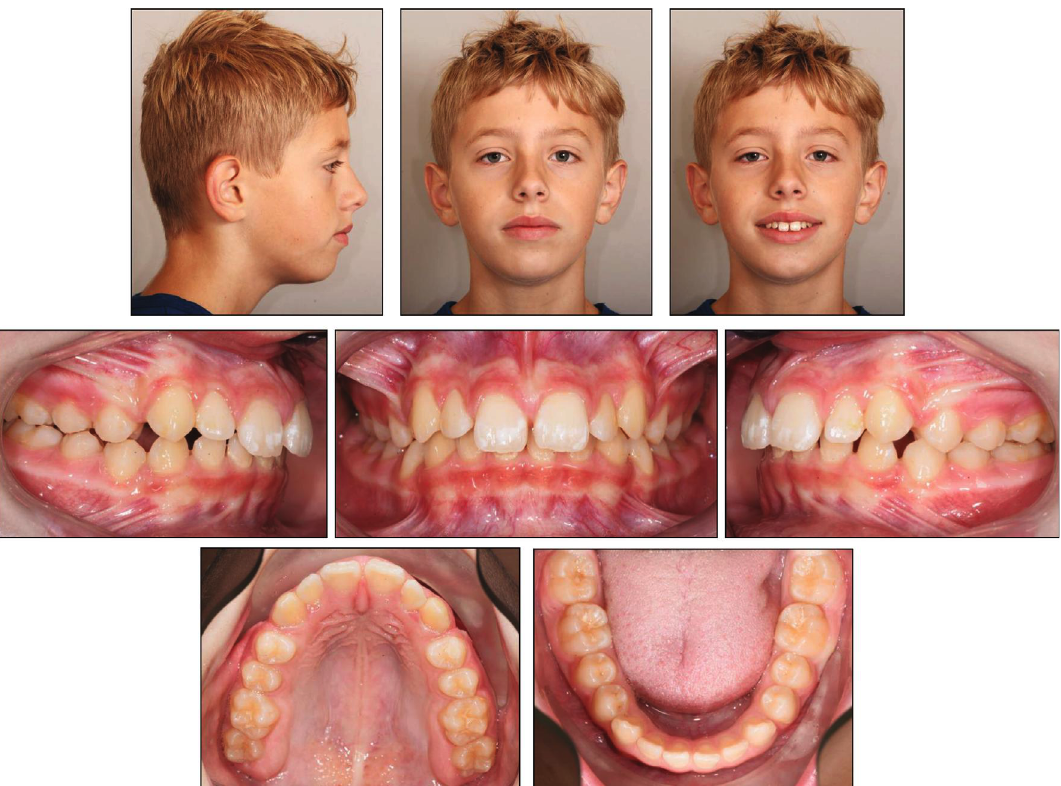
Figure 1: The patient ’ s facial and intraoral photographs taken before treatment at the age of 12 years and one month.